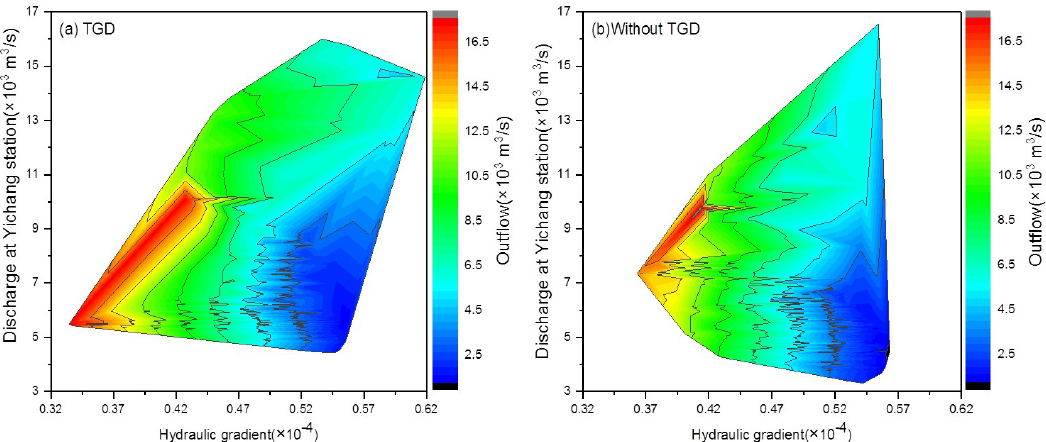
Figure 11. Outflow processes with the discharge and hydraulic gradient during the dry seasons (December to the following April) from 2008 to 2011. The outflow of the Dongting Lake was observed at the Chenglingji station; the hydraulic gradient was between the Zhicheng and Chenglingji stations.